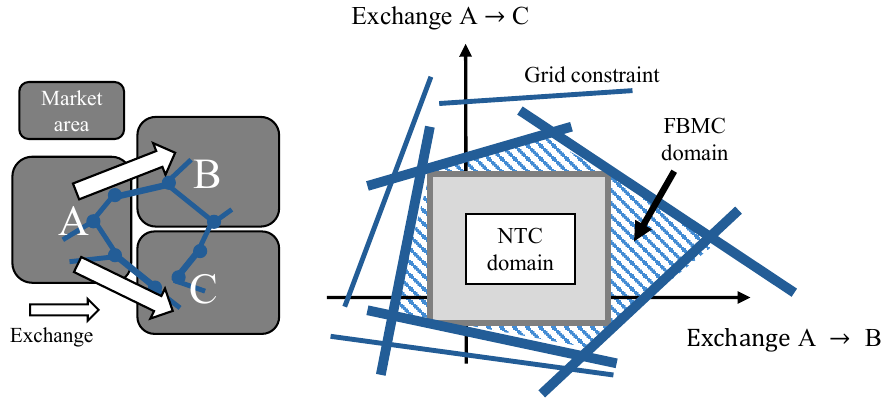
Figure 4. Comparison of the exchange domain between NTC and